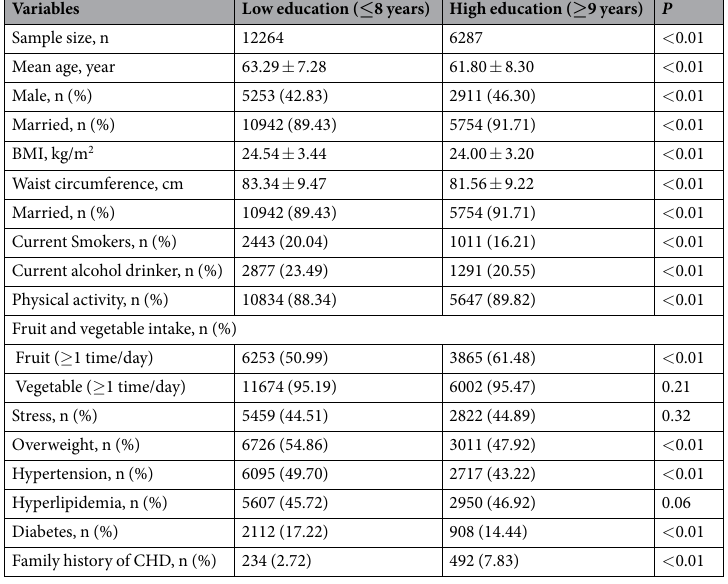
Table 1. Baseline characteristics of the study subjects according to the type of educational levels. Abbreviation: CHD, coronary heart disease; BMI, body mass index. Data are mean ± standard deviation for continuous variables and number (%) for categorical variables. P values were calculated using student’s t-test for continuous variables and chi-square test for categorical